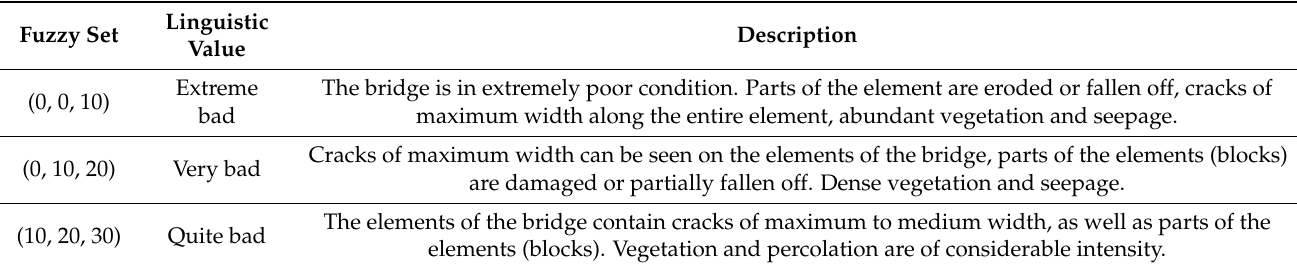
Table 2. Fuzzy sets of element ratings with linguistic values and